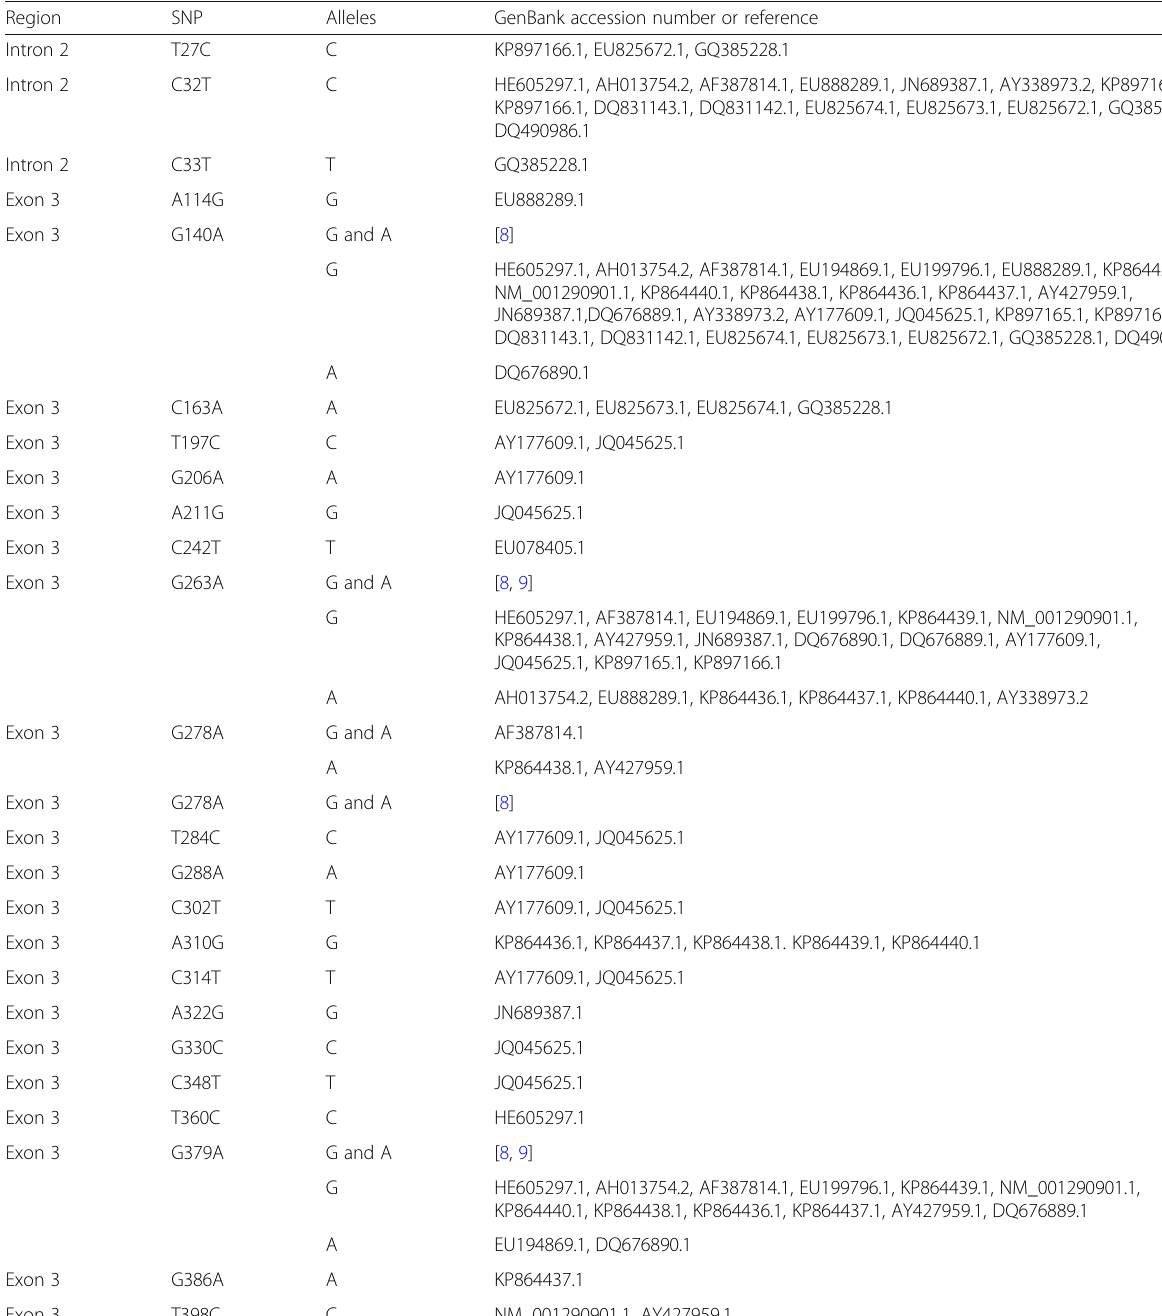
Table 1 Detected SNPs in the amplified LEP sequence and its homologs Bubalus bubalis sequences in the GenBank database and previous